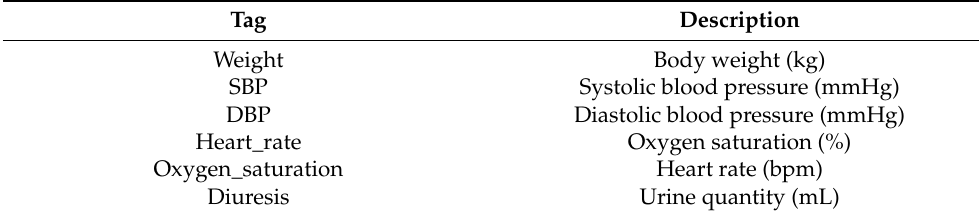
Table 1. Daily monitored vital